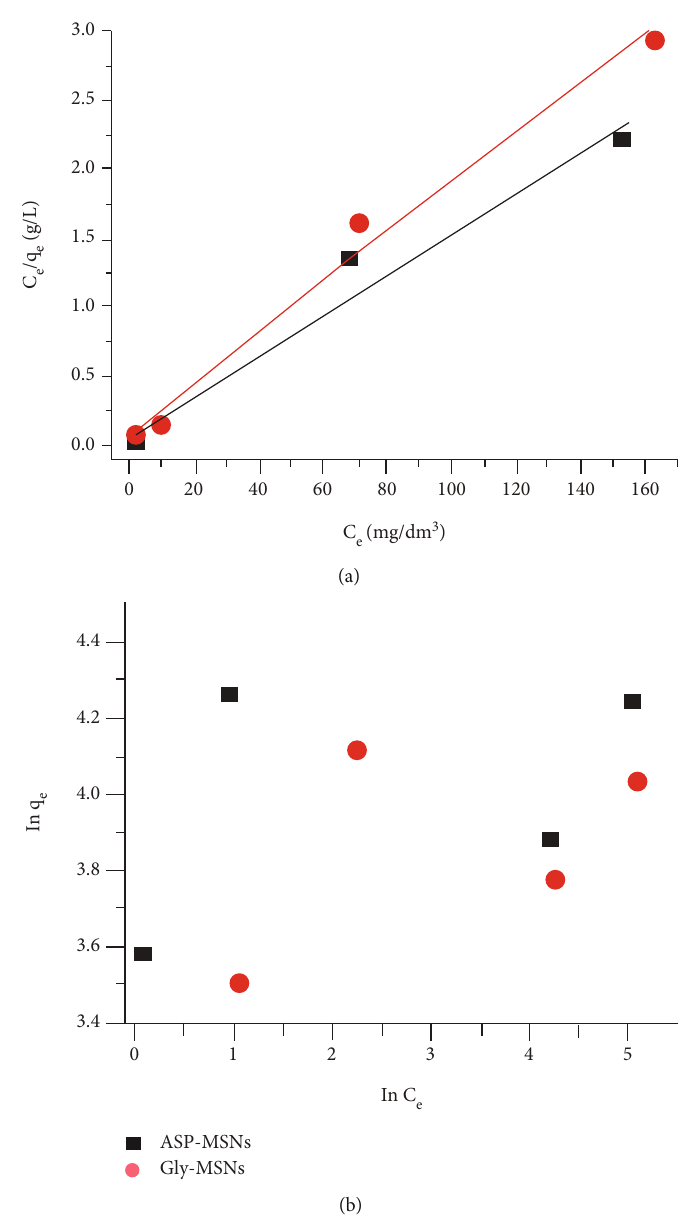
Figure 9: (a) Langmuir adsorption isotherm fi t of MB onto Asp-MSNs and Gly-MSNs, and (b) Freundlich adsorption isotherm fi t of MB onto Asp-MSNs and Gly-MSNs ( m =10mg, V =10mL, pH=7, and T